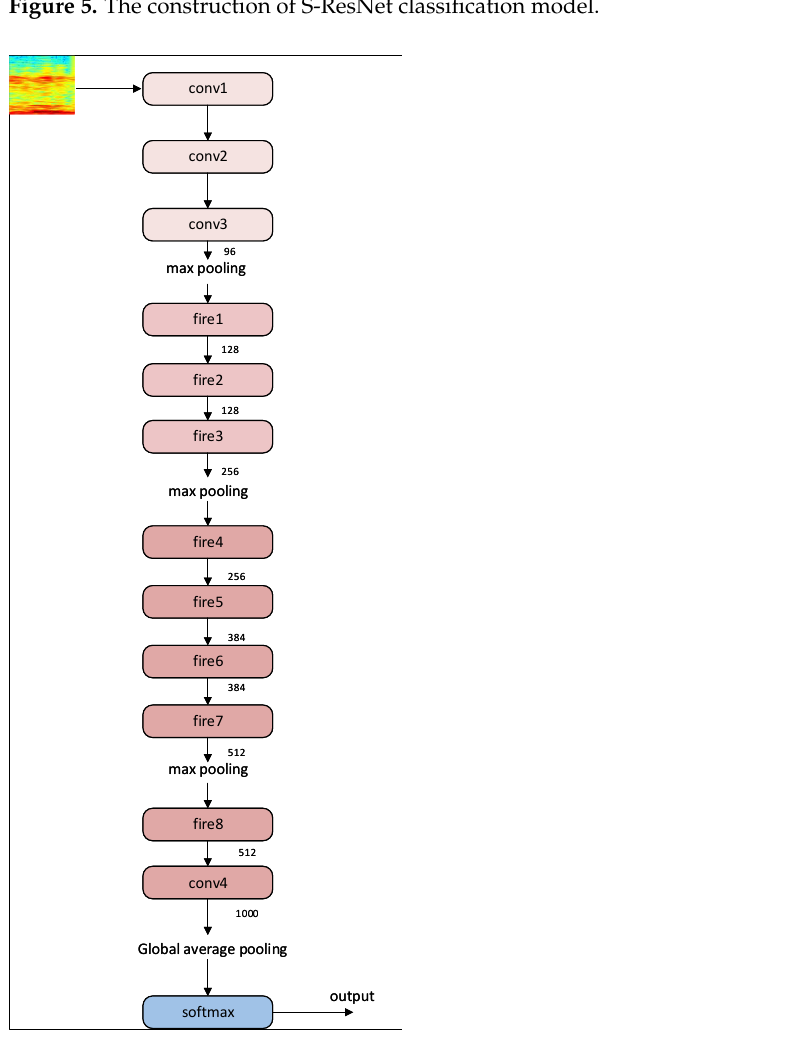
Figure 5. The construction of S-ResNet classification model.